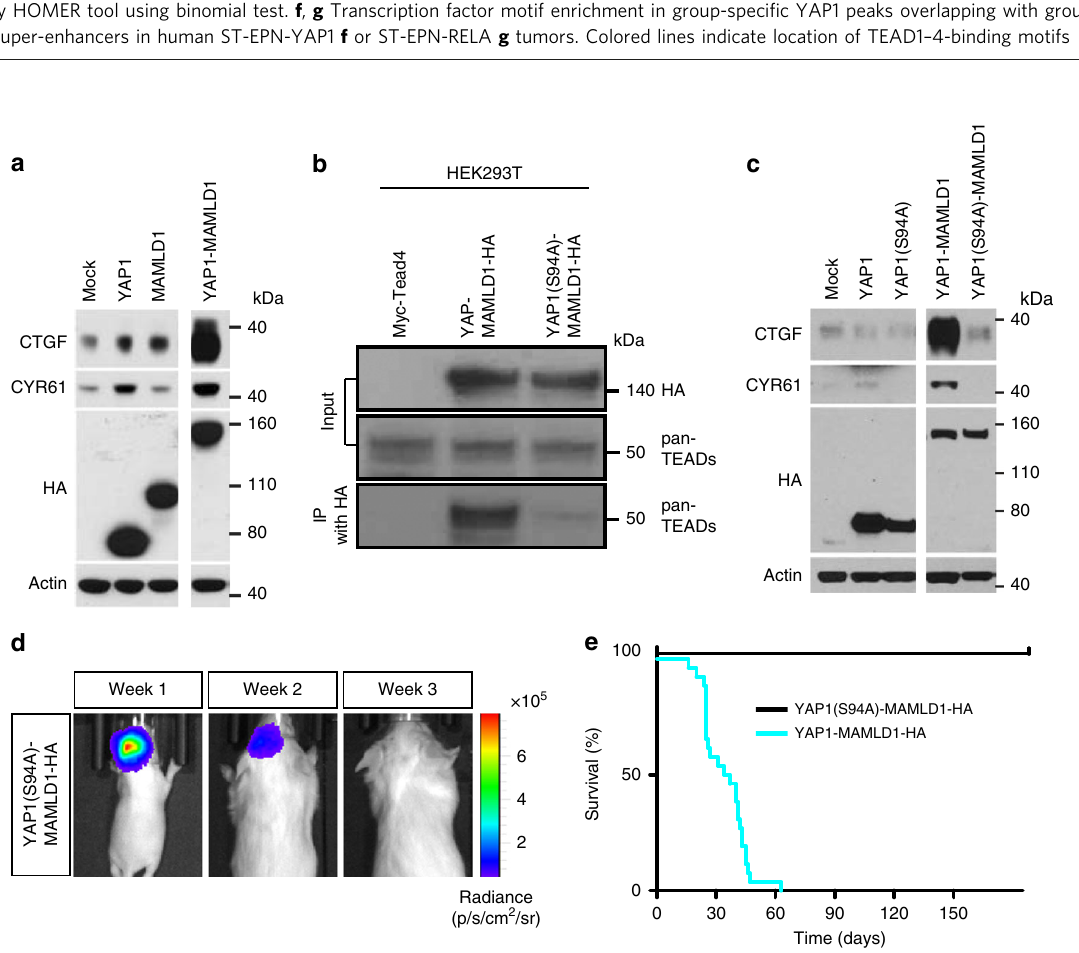
Fig. 6 The YAP1-MAMLD1 exerts its oncogenicity via TEAD-mediated transcriptional control. a Western blot of human CTGF and CYR61 in LN229 cells transiently transfected with indicated genes. The transgene protein products were tagged by HA. b Western blot of pan-TEAD proteins (pan-TEADs) after immunoprecipitation with an anti-HA antibody for HA-tagged YAP1-MAMLD1 fusion protein, con fi rming that the S94A-mutated YAP1-MAMLD1 fusion has lost the ability to bind TEAD transcription factors. c Western blot of YAP1-Tead targets CTGF and CYR61 using NIH/3T3 cells transfected with indicated genes. The transgene protein products were tagged by HA. d , e Luciferase-based d in vivo bioluminescence images at weeks 1 – 3 after birth and e Kaplan – Meier curves of animals electroporated with S94A-mutated YAP1-MAMLD1 fusion. Cyan curve is same as in Fig. YAP1-MAMLD1 but not YAP1 in HEK293T cells and human primary ST-EPN-YAP1 cells (Fig. 7a, b and Supplementary Fig. 7a). ChIP-seq on human ST-EPN-YAP1s with an anti-NFIA antibody found that NFIA peaks overlapped with 96% of YAP1- interacting loci (1201 out of 1246 peaks), while this overlap was 13% in ST-EPN-RELAs (337 out of 2464 peaks) (Fig. 7c). As reported in the previous study with murine neural stem cells 37 , NFIA binding was detected in the loci of TEAD-mediated YAP1 target genes CTGF and CYR61 in ST-EPN-YAP1s (Supplementary Fig. 7b, c). Thus, YAP1-MAMLD1 and NFI proteins seem to interact via the MAMLD1 domain in ST-EPN-YAP1s. Since the YAP1-bound genes with NFI-binding motifs were marked by the activating histone modi fi cation H3K27Ac (Fig.